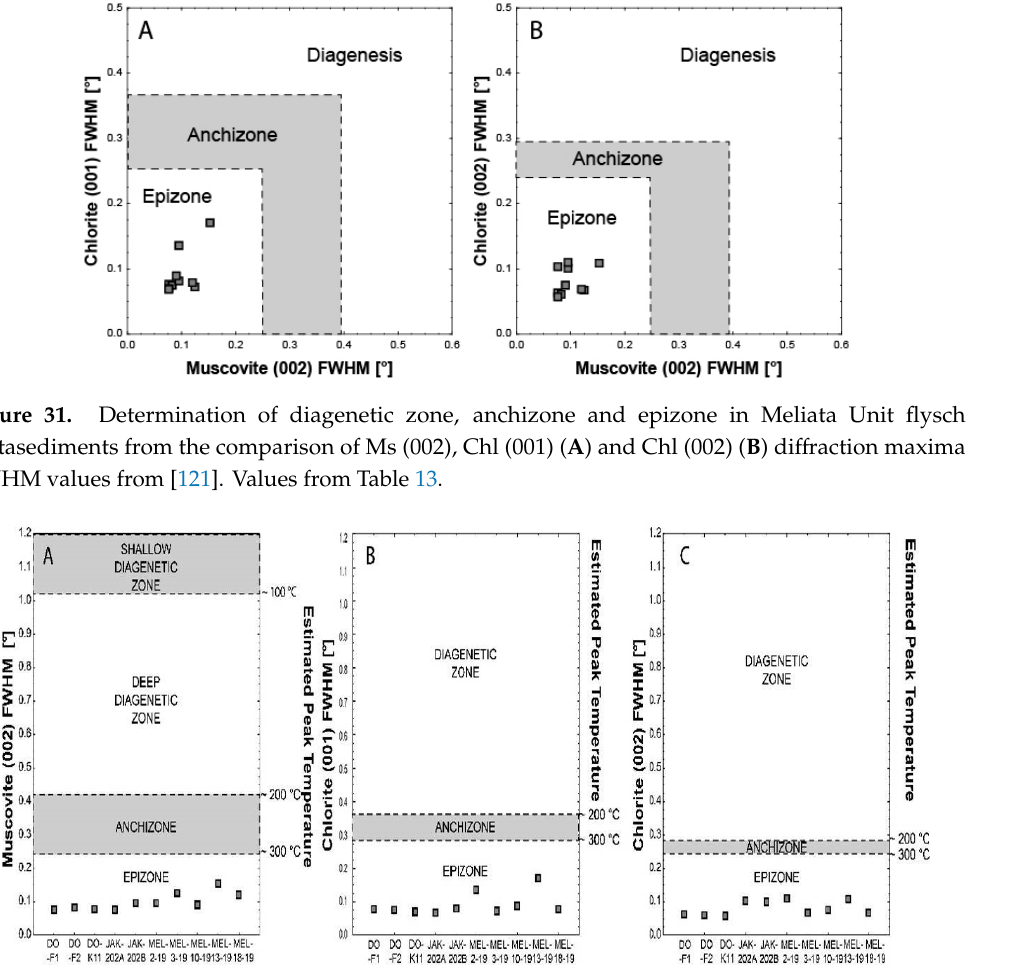
Figure 32. Determination of diagenetic zone, anchizone and epizone in Meliata Unit flysch metasediments from the comparison of Ms (002) ( A ) and Chl (001) ( B ) and (002) ( C ) diffraction maxima FWHM values according to [122,123]. Values from Table 13.